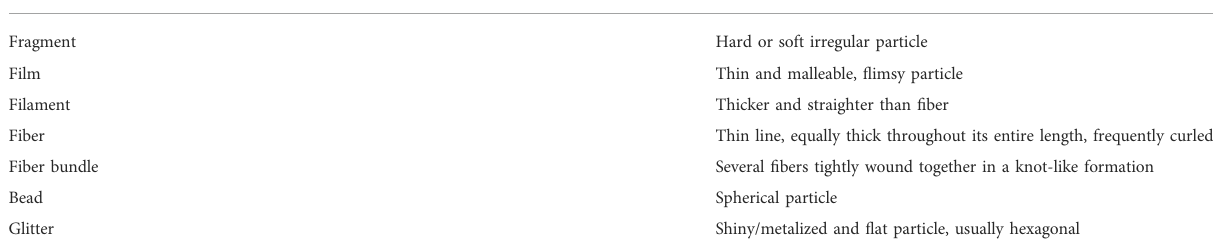
TABLE 1 De fi nition of each particle type.